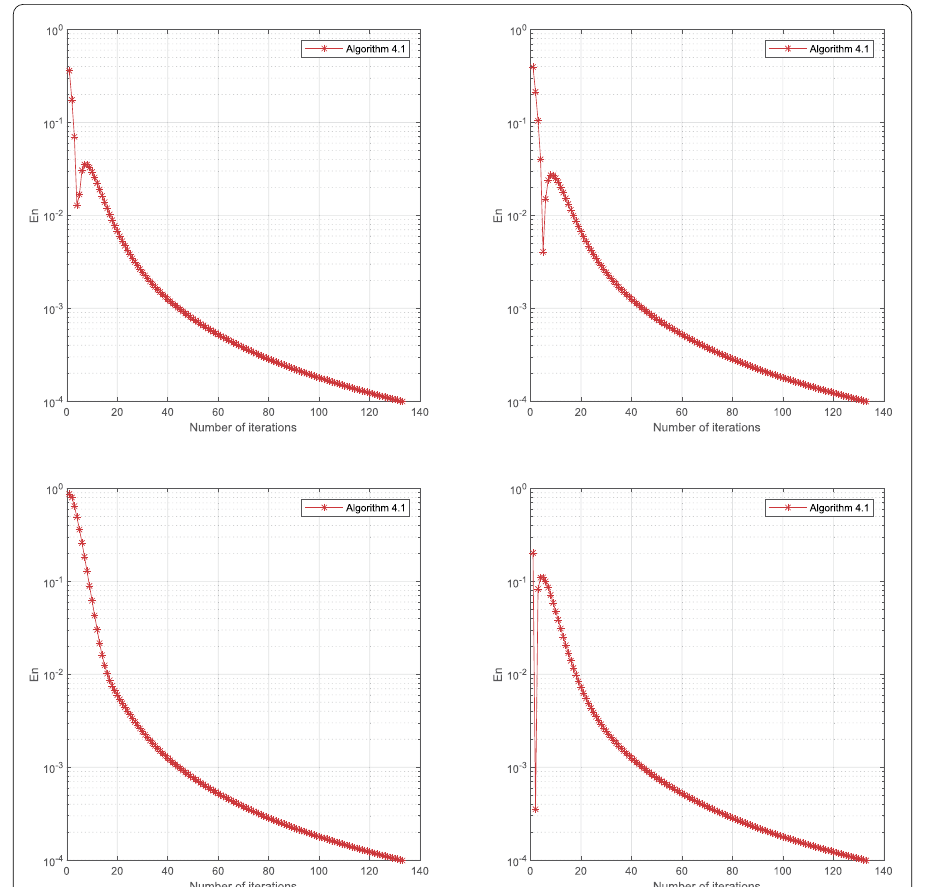
Figure 1 Example 6.1, Top left: Case 1; Top right: Case 2; Bottom left: Case 3; Bottom right: Case